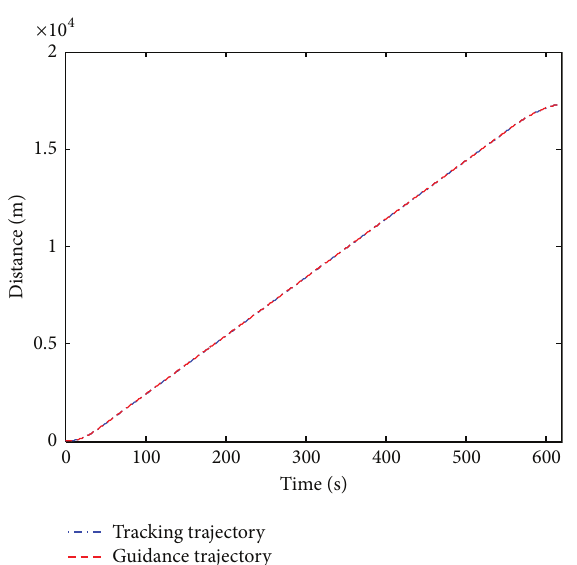
Figure 4: Train distance tracking curve (this paper).